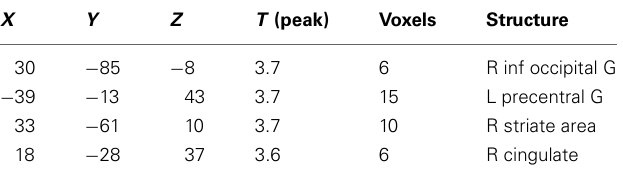
Table 6 | Brain activation due to ambroxan within a mixture in ambroxan; difference between sensitive and insensitive subjects; (masked ALL vs. CON) ( p < 0 . 001;